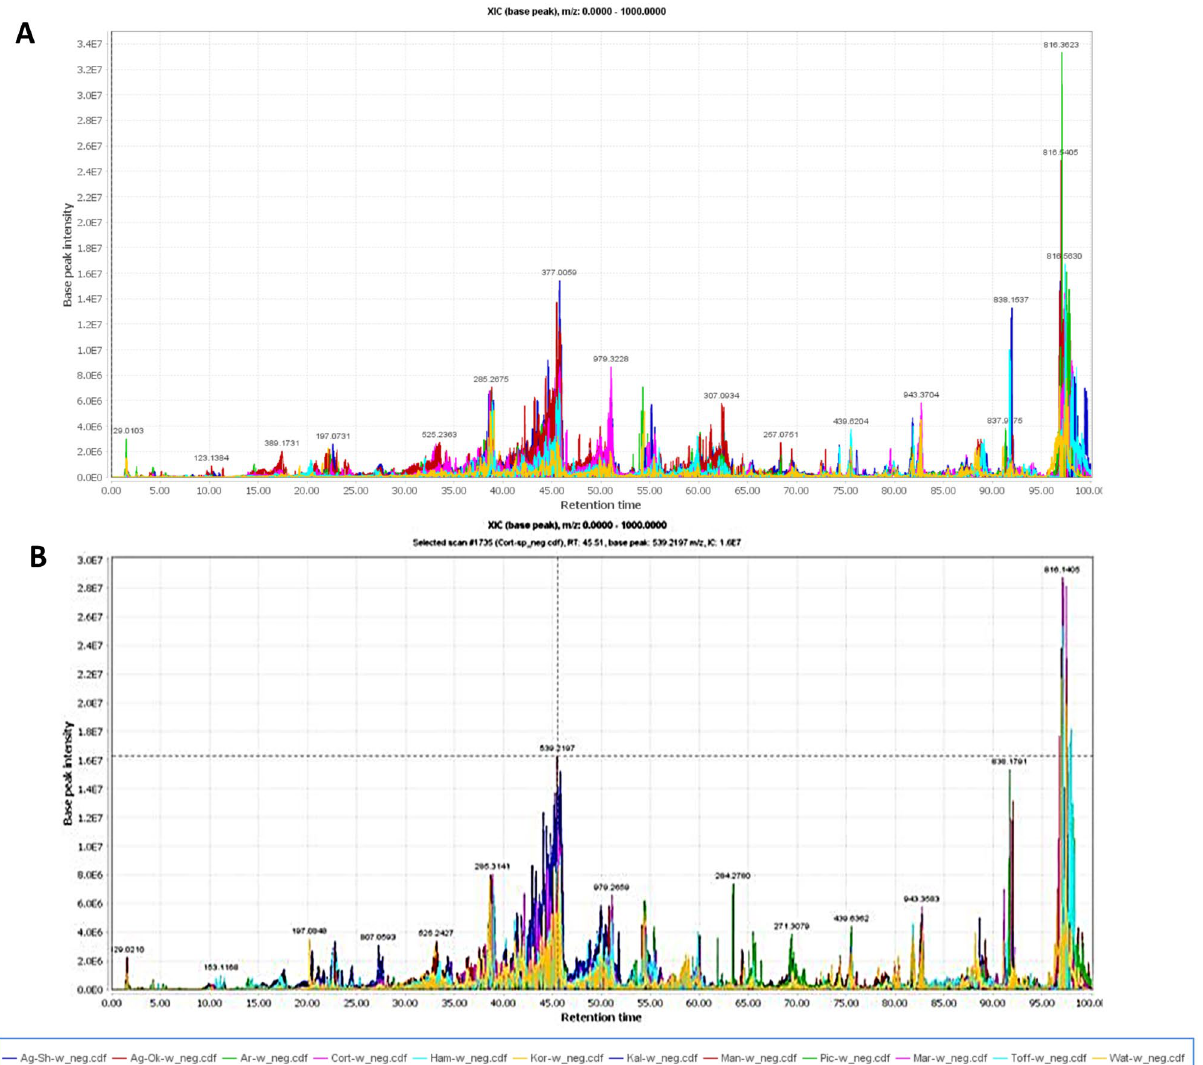
Figure 1. Total ion chromatogram of olive leaves from twelve cultivars collected in autumn ( A ) and spring ( B ), in the negative ionization